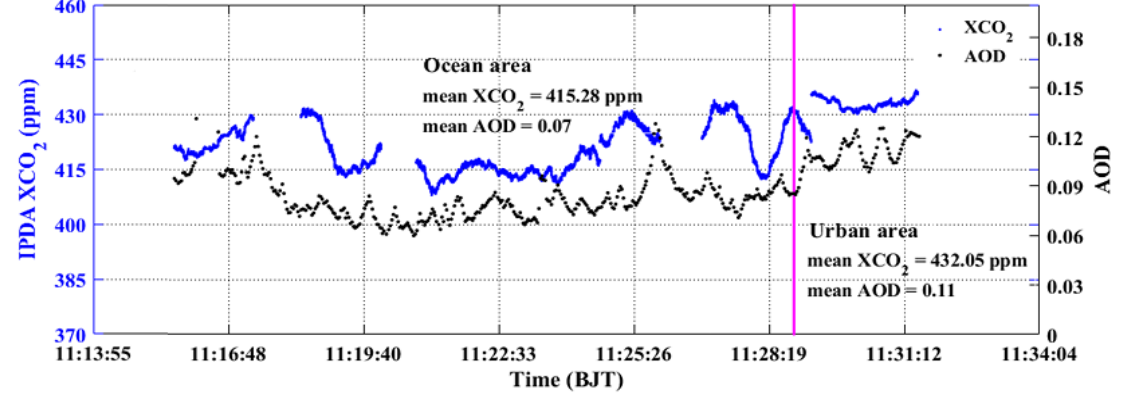
Figure 17. Comparison of AOD and XCO 2 measured by the airborne ACDL system in marine and urban areas on 14 March 2019 . The blue scatters represent XCO 2 and the black scatters represent AOD. The pink vertical line is the dividing line between the marine area and the urban area.